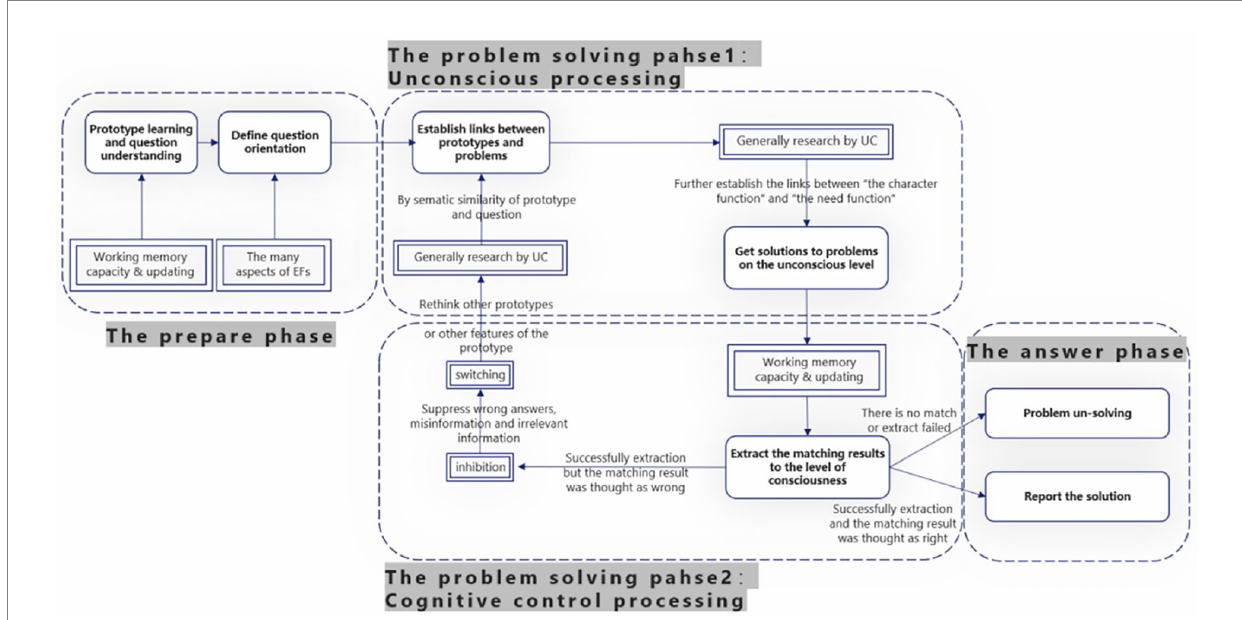
FIGURE 7 An insight prototype heuristic model of executive functions and unconsciousness. This model is only applicable to the problem-solving process of difficult insight problems with unconscious